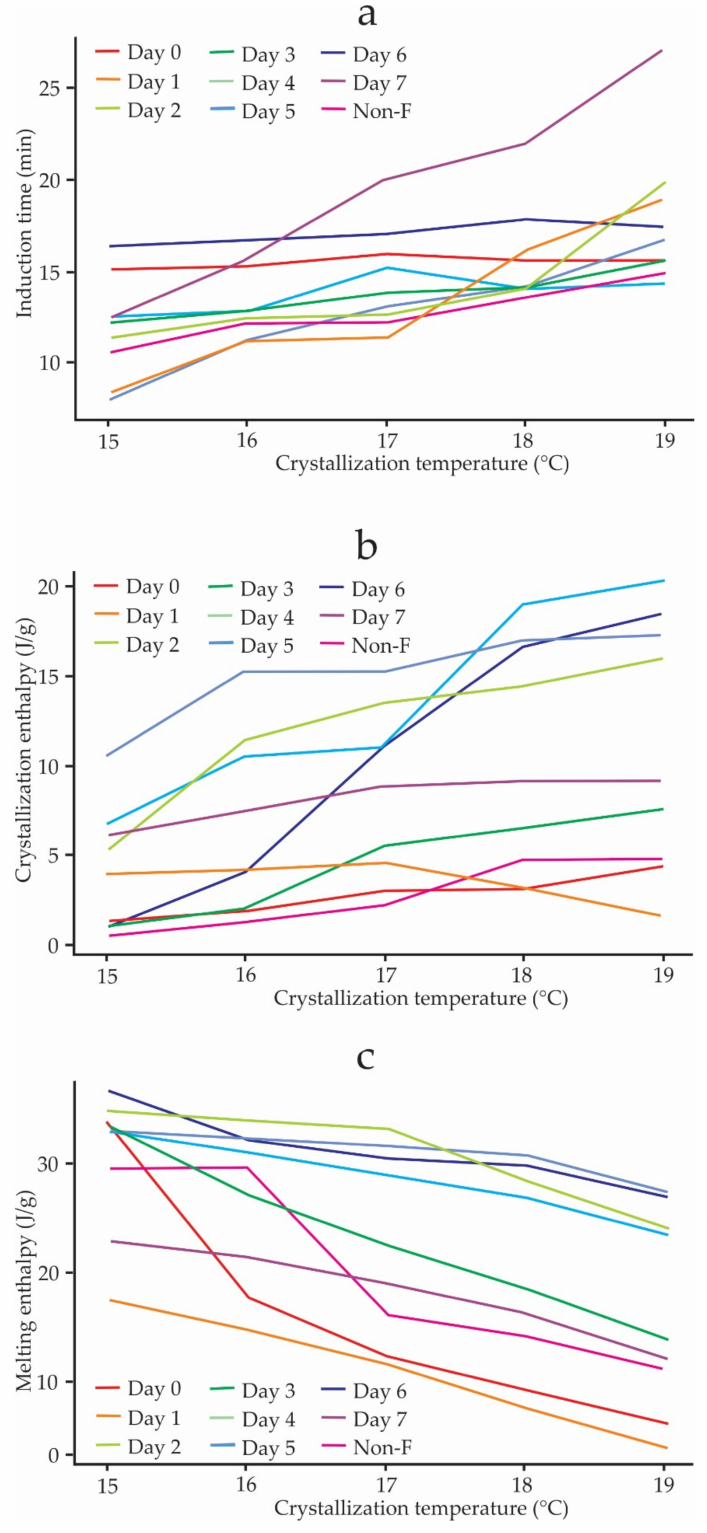
Figure 3. Induction times ( a ), crystallization enthalpy ( b ), and melting enthalpy ( c ) of the CB inside cocoa beans as a function of T c during spontaneous